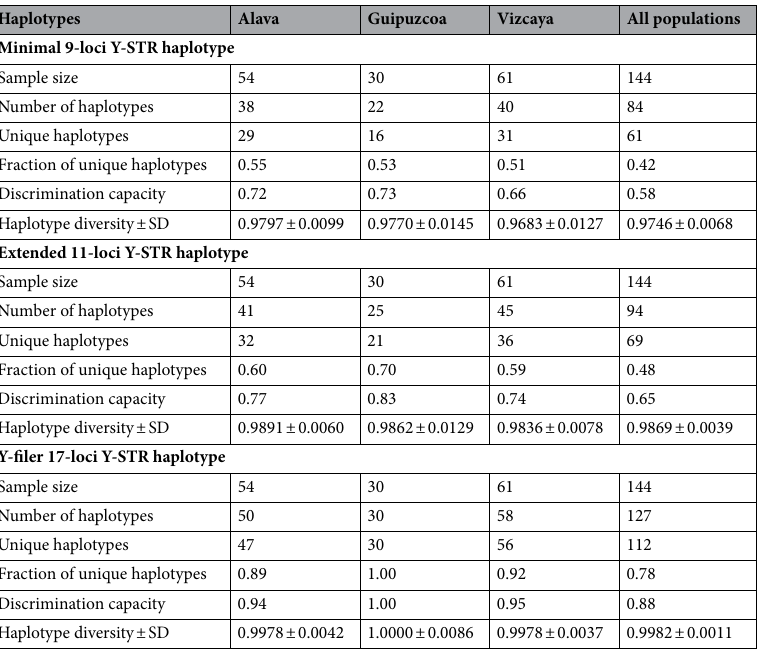
Table 1. Forensic and population genetics parameters of the Alava, Guipuzcoa and Vizcaya Basque populations using the minimal, extended and the Yfiler